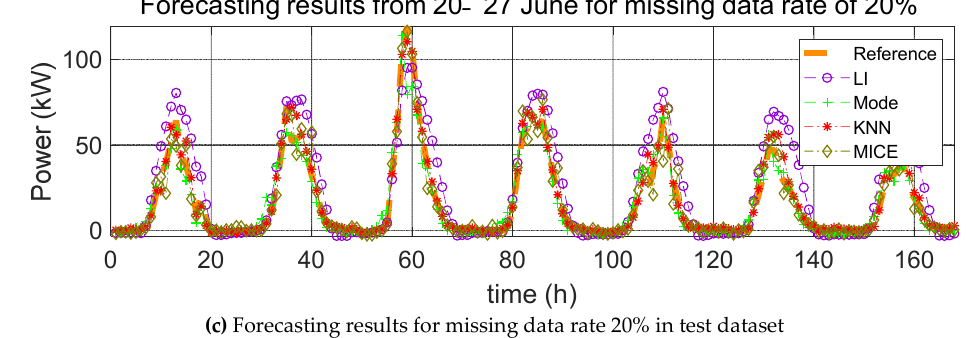
(c) Forecasting results for missing data rate 20% in test dataset Figure 11. Forecasting results from 20 – 27 June for various missing data rates (10%, 15%, and 20%). Figure 11. Forecasting results from 20–27 June for various missing data rates (10%, 15%, and